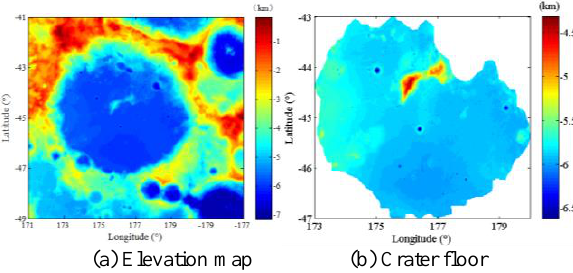
Figure 3 Elevation map of Von Kármán crater and its floor (http://pds-geosciences.wustl.edu/lro/lro-l-lola-3-rdr-